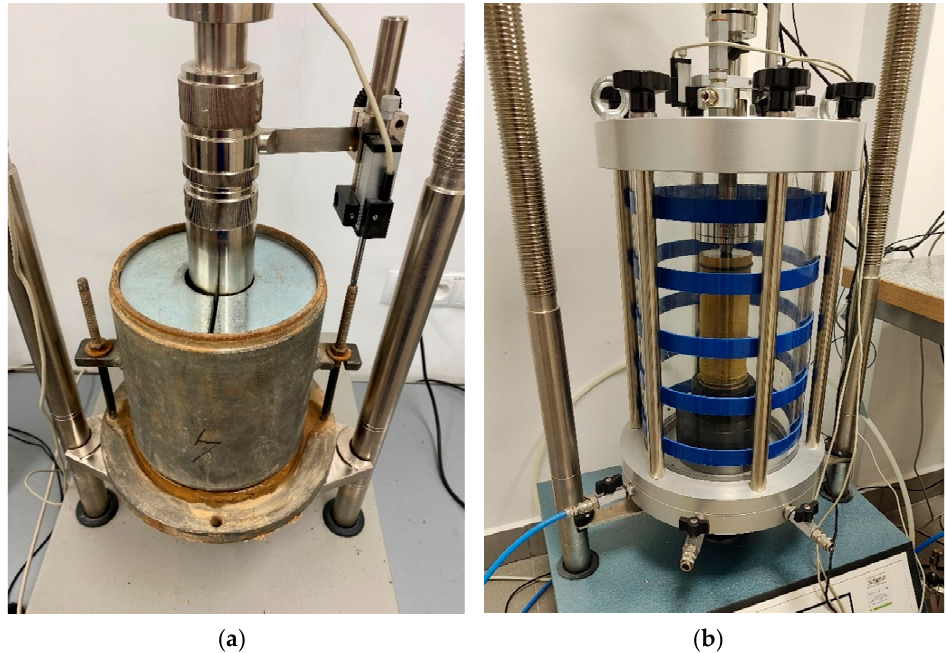
Figure 4. Image of a loaded sample prior to the test: ( a ) in the CBR mold, ( b ) in the chamber of the cyclic triaxial apparatus. cyclic triaxial